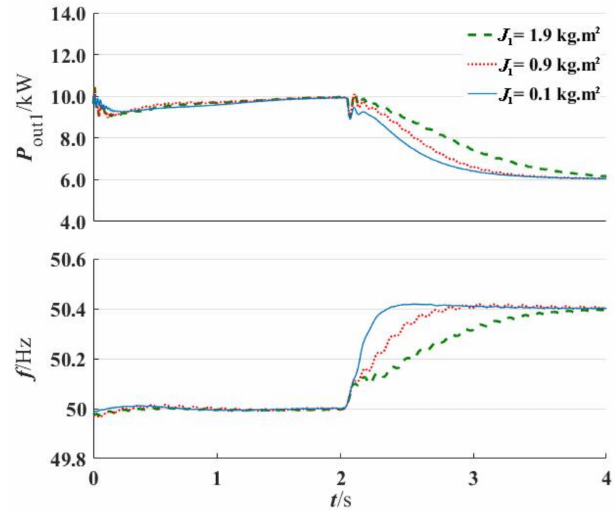
Figure 22. The influence of different inertia on the system